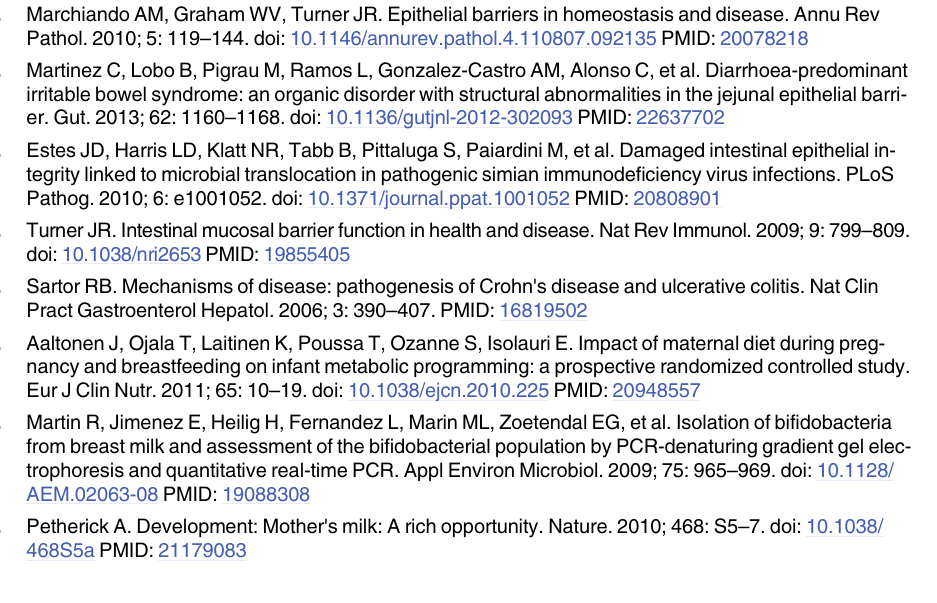
S1 Fig. Binding Control Tests for IgA ELISA. S2 Fig. Binding Control Tests for IgM ELISA. S3 Fig. Specificity Control Tests for IgG ELISA. S4 Fig. Specificity Control Tests for IgA ELISA. S5 Fig. Specificity Control Tests for IgM